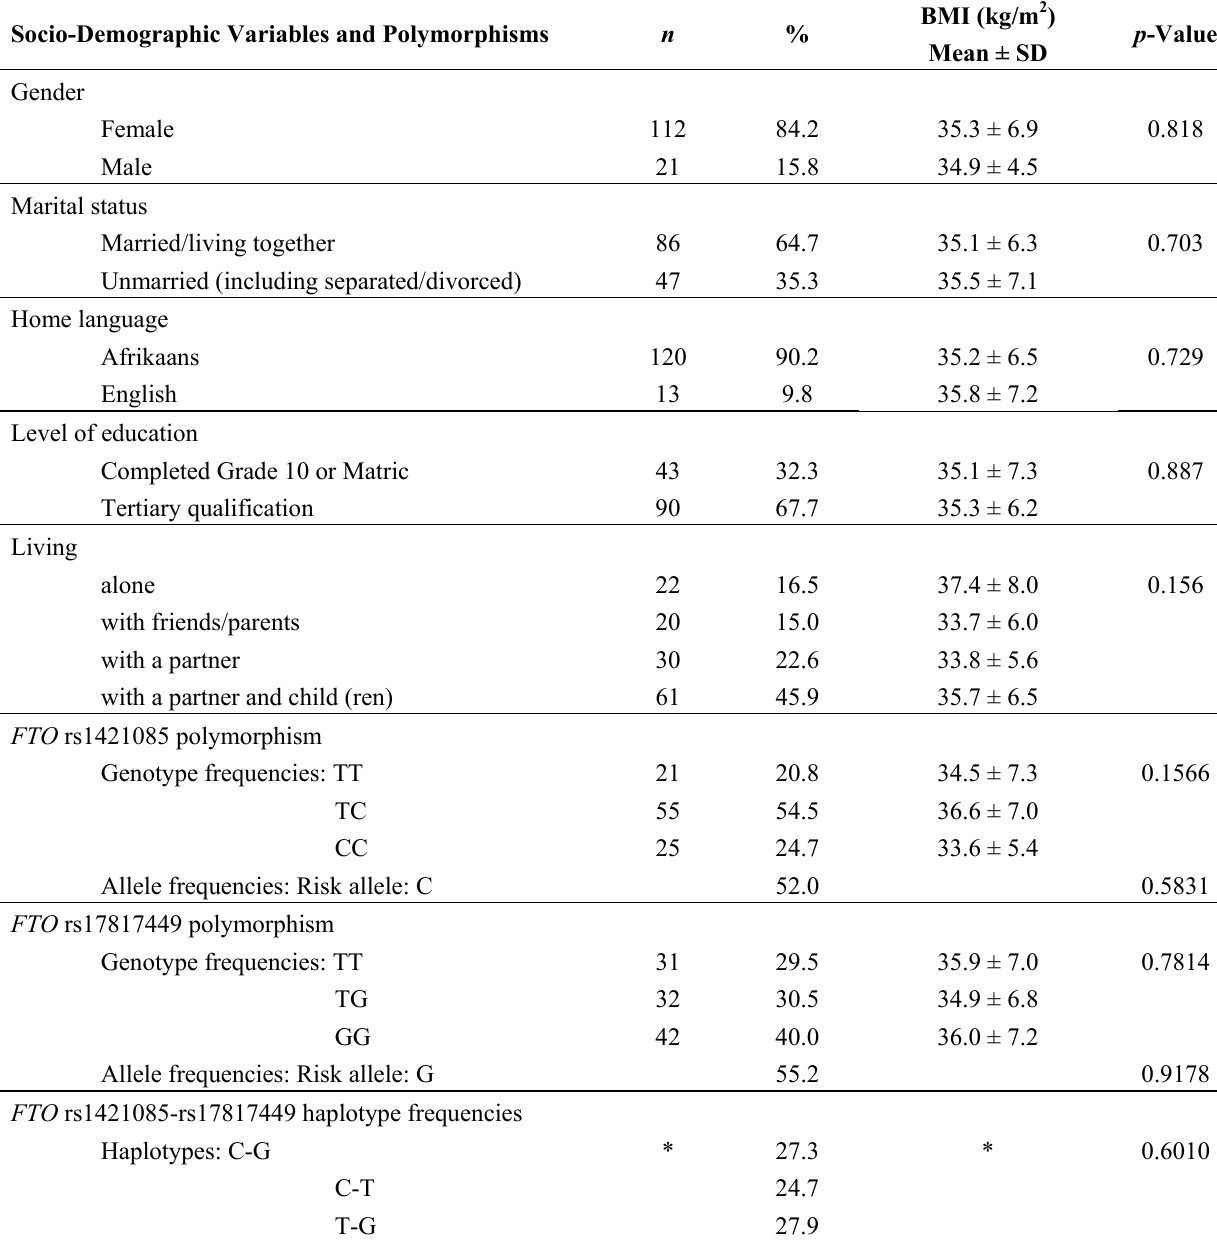
Table 2. Socio-demographic profile and genotype, allele and haplotype frequencies of the FTO rs1421085 and rs17817449